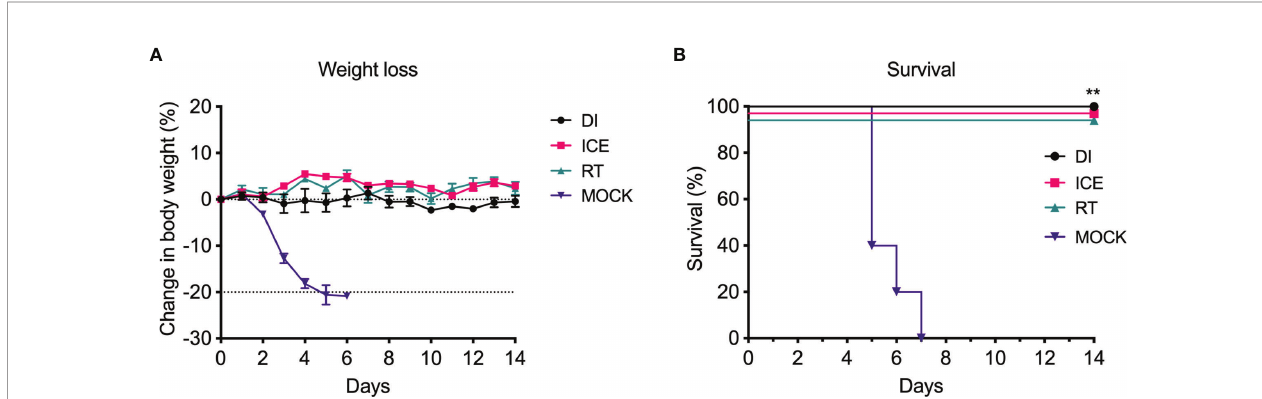
FIGURE 4 | Vaccination with g -Flu protects against lethal homotypic challenge. Mice were vaccinated intranasally with g -Flu irradiated at different temperatures (DI, Ice and RT), or PBS-mock control. 21 days later, mice were intranasally challenged with a lethal dose of A/PR8. (A) Weight was monitored daily and a 20% loss of starting weight was considered as the humane endpoint (dotted line), at which point mice were euthanised. (B) Overall survival was plotted, and a two-tailed Fisher Exact test was used to determine statistical signi fi cance compared to the Mock control group (**P < 0.01, n = 5 mice per